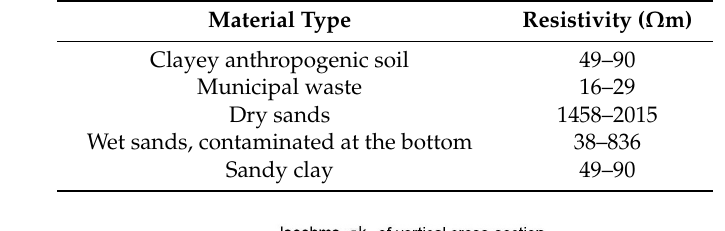
Table 3. Subsoil resistivity characteristics.